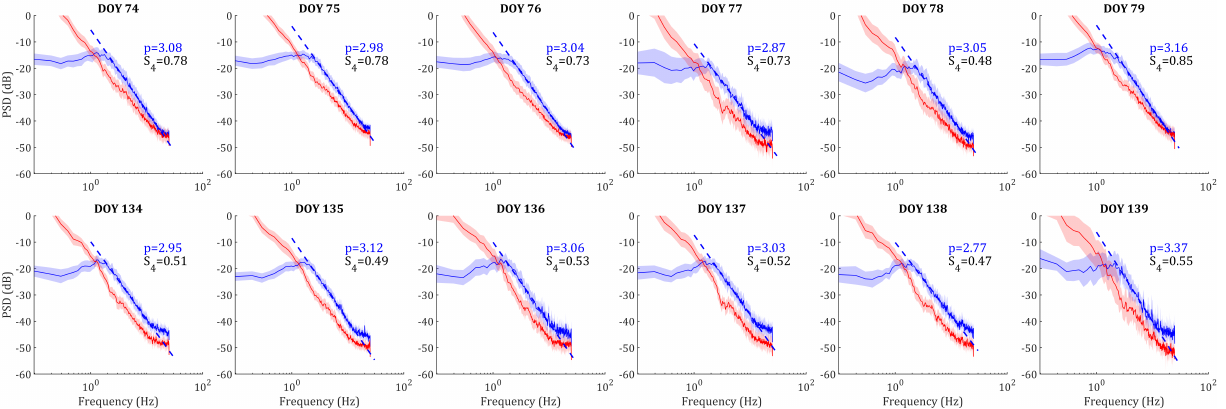
Figure 10. Daily averaged PSDs for label 1 observations. Blue curves correspond to intensity, red corresponds to the phase, and shaded regions to the 95% confidence interval. Spectral slopes estimated by least squares fit within 2.77 and 3.37, with phase slopes closely following the trend. The S 4 index corresponds to the average among label 1 cases in each